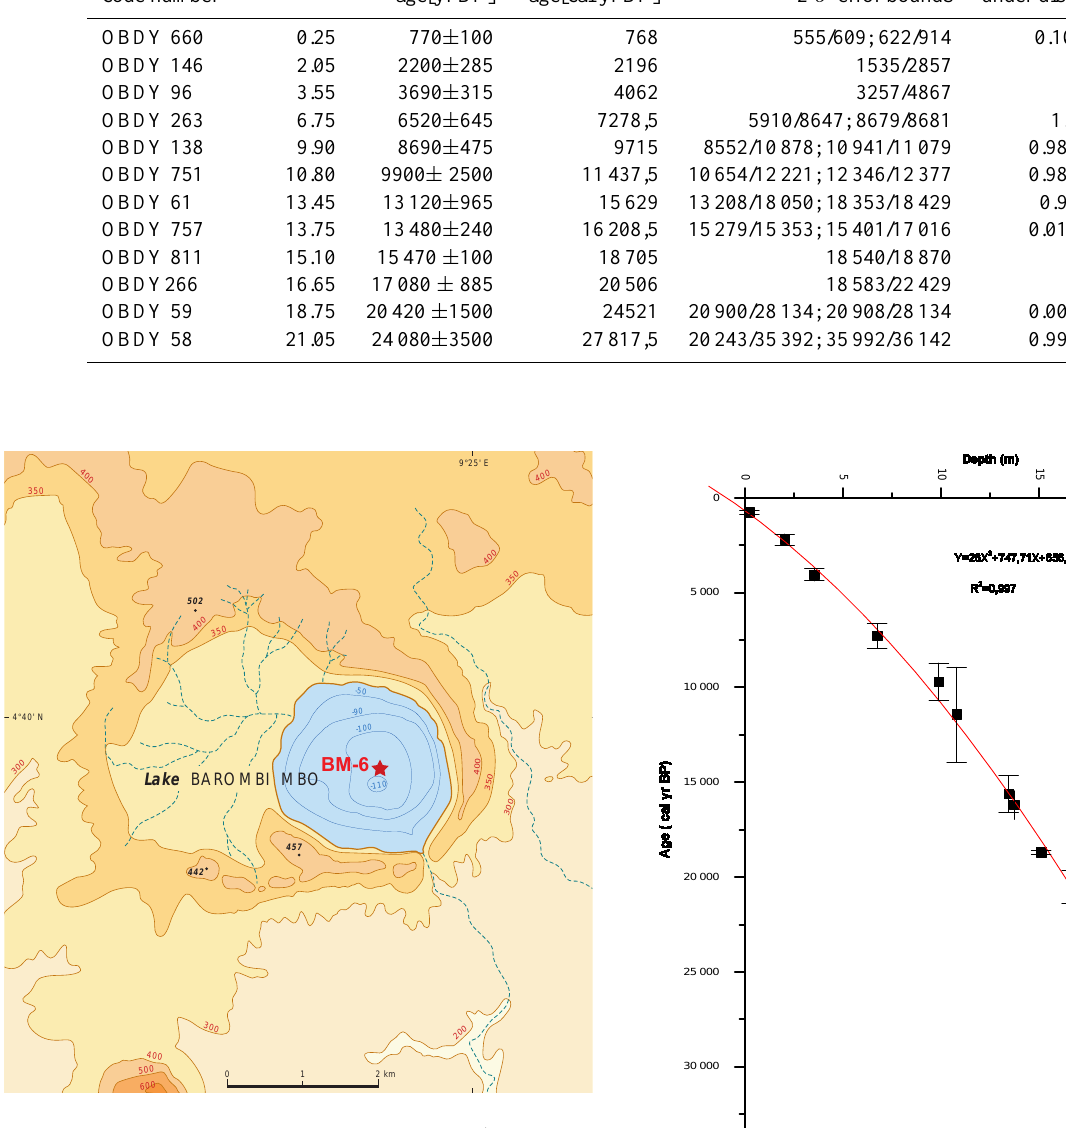
Fig. 2. Lake Barombi Mbo. Location of core BM-6 (after Giresse et al., 1991).